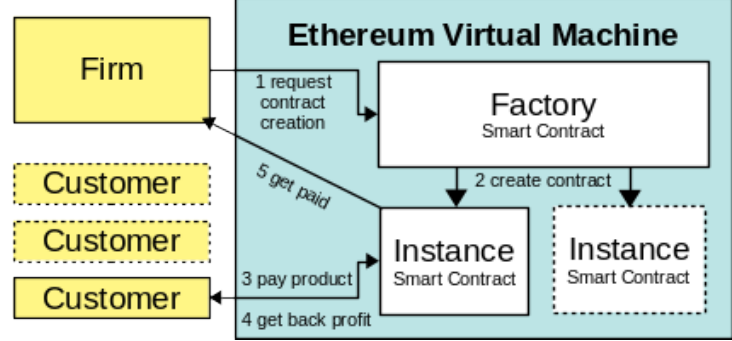
Figure 3. Factory architecture for the proposed